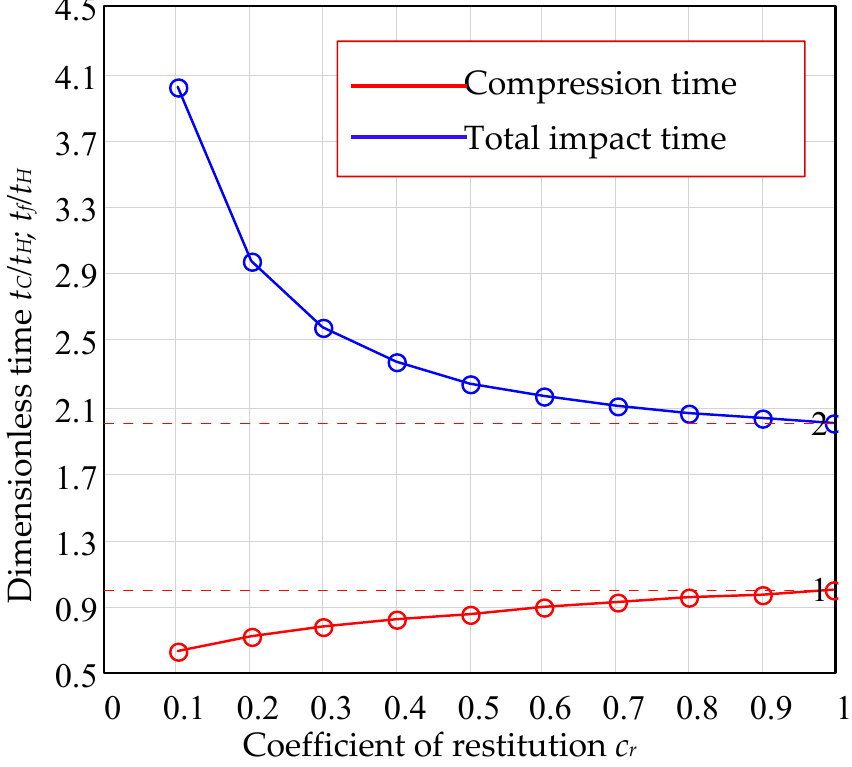
Figure 27. Dependency of compression time ( t C ) and total impact time ( t f ) on coefficient of restitution ( c r ) .